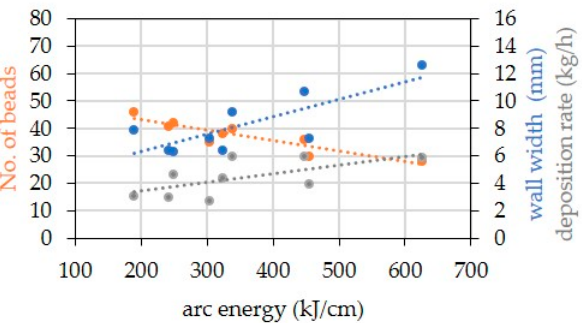
Figure 1. Influence of arc energy on number of layers, walls width, and deposition rate when welded the walls with variable process parameters from Table 2.